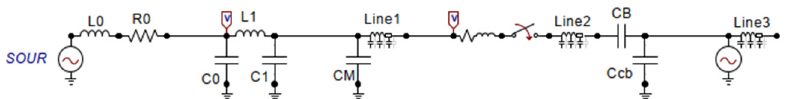
Table 10. Changes in radial capacitance values.